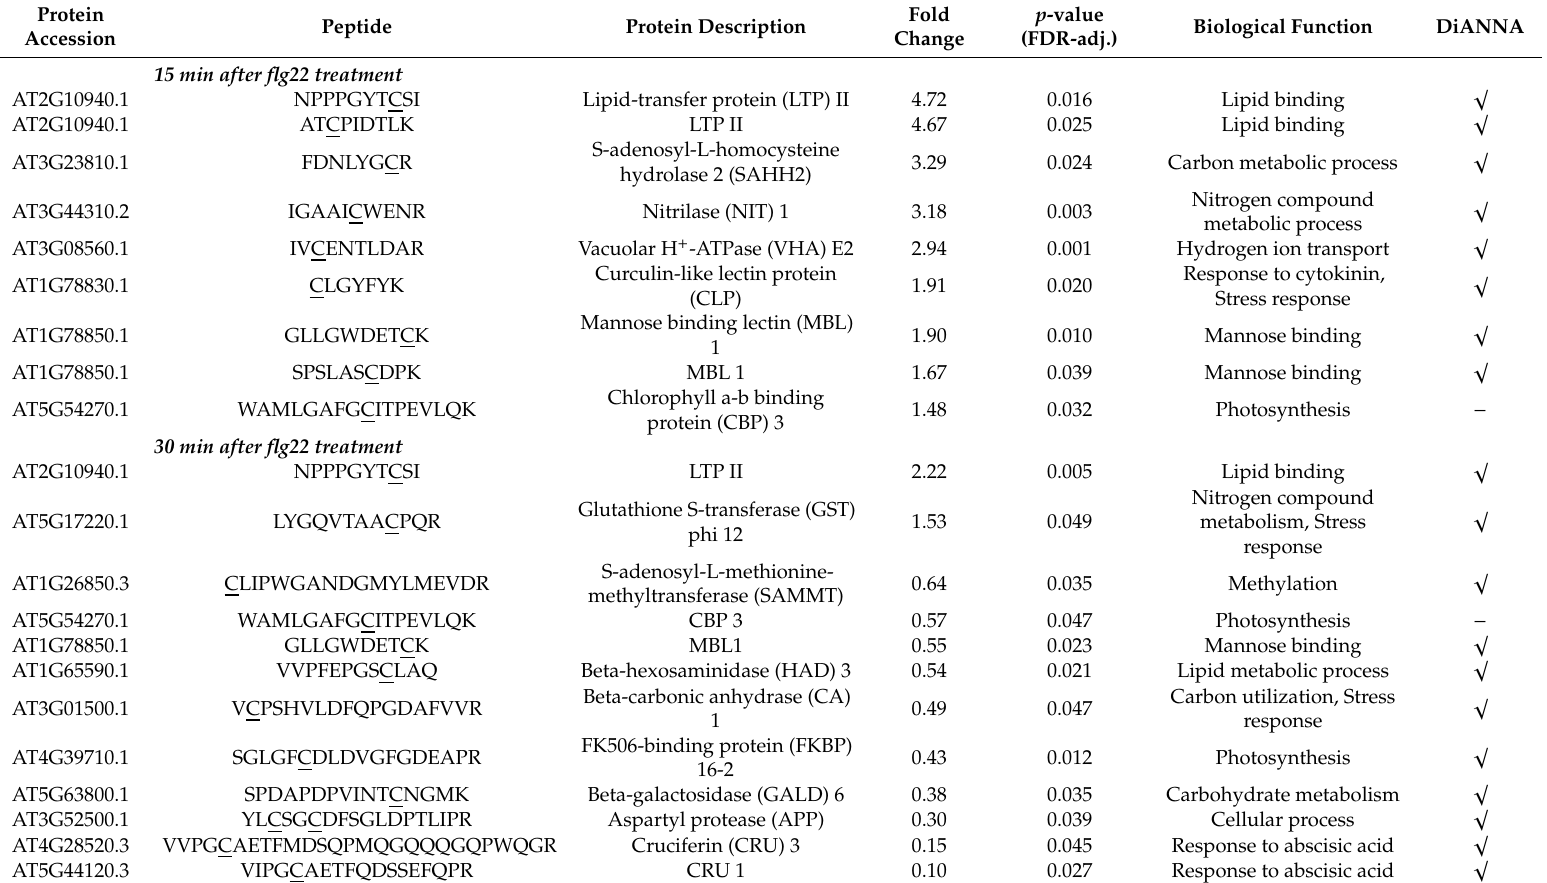
Table 1. S-nitrosylated proteins identified in guard cells after flg22 treatment for 15 min, 30 min and 60 min. The tick under DiANNA indicates the predicted cysteine residue involved in disulfide bond